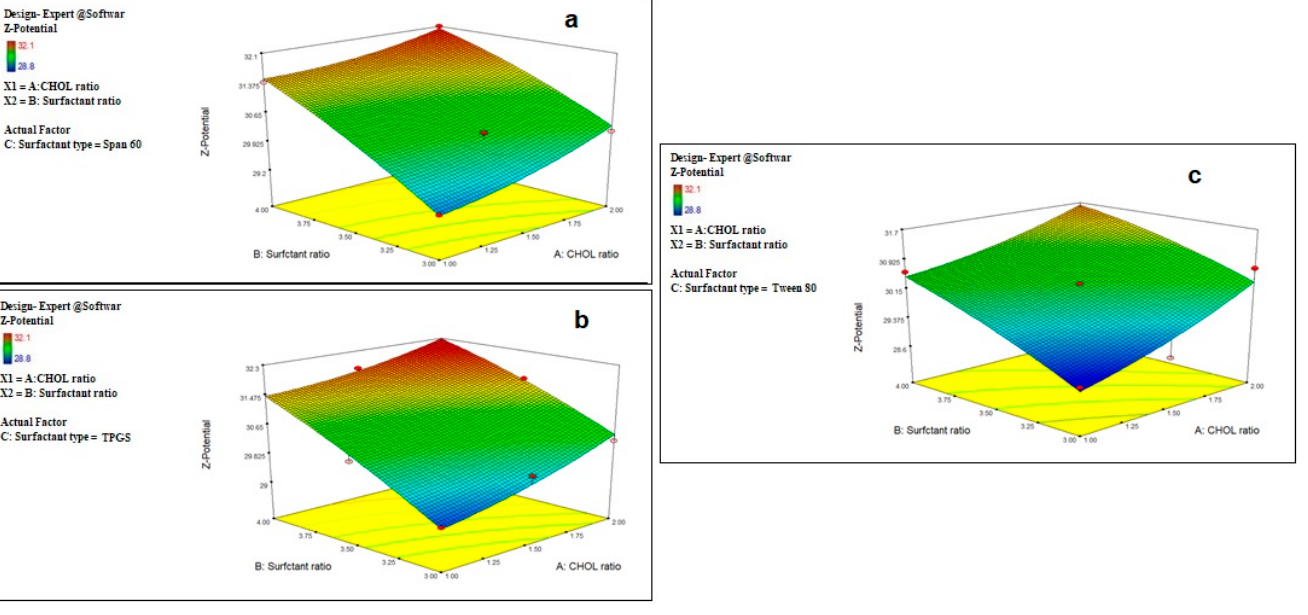
Figure 2. Effect of CHOL and surfactant ratio on the Z-potential of drug-free niosomes at different surfactant types (( a ): Span 60, ( b ): TPGS, ( c ): Tween 80). surfactant types (( a ): Span 60, ( b ): TPGS, ( c ): Tween